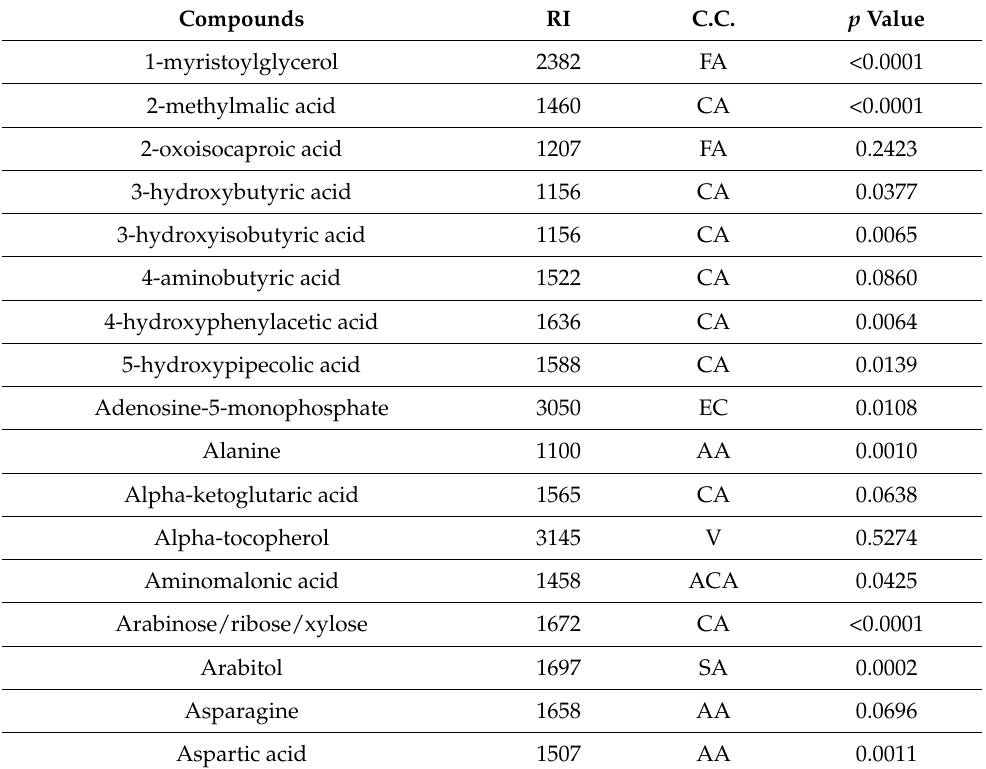
Table 2. Metabolites detected in Chlorella strain and their retention indexes (RI), compound classes (CC; FA = fatty acids; CA = carboxylic acids; AA = amino acids; EC = energy compound; V = vitamins; P = phenols; ACA = amino carboxylic acid; Carb= carbohydrates; AlA = alkylamines; Carb= carbohy- drate; AM = amides; SP = sugar phosphates; L = lipids) and P values. The P values of differences in levels of the metabolites between algae grown in autotrophic and heterotrophic conditions with glycerol are according to t -tests. Mean ± standard errors, n =